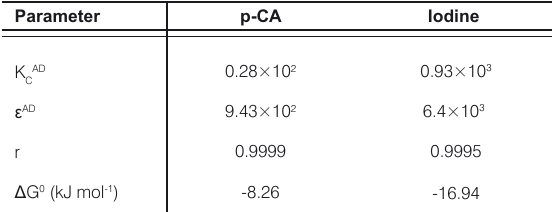
Figure 3. Job’s method for SU complexes. Total molar concentration = 8×10 -4 and 1×10 -4 M for p-CA and iodine, respectively; (a) p-CA, λ = 518 nm and (b) Iodine, λ = 363 nm. Table 1. Association constant K CAD , molar absorptivity values ε AD , correlation coefficients r from Benesi-Hildebrandt plots for the complex and the calculated Δ G 0 .